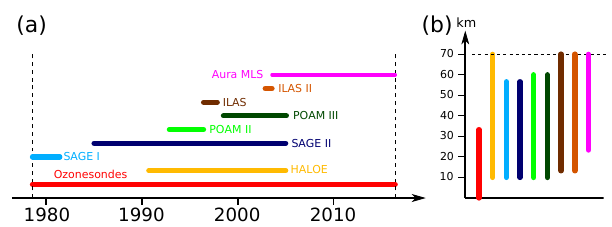
Figure 1. Temporal (a) and vertical coverage (b) of the differ- ent ozone data sources used to create the BSVertOzone database. Dashed lines in both parts of the figure denote the BSVertOzone database temporal (1979–2016) and vertical boundaries